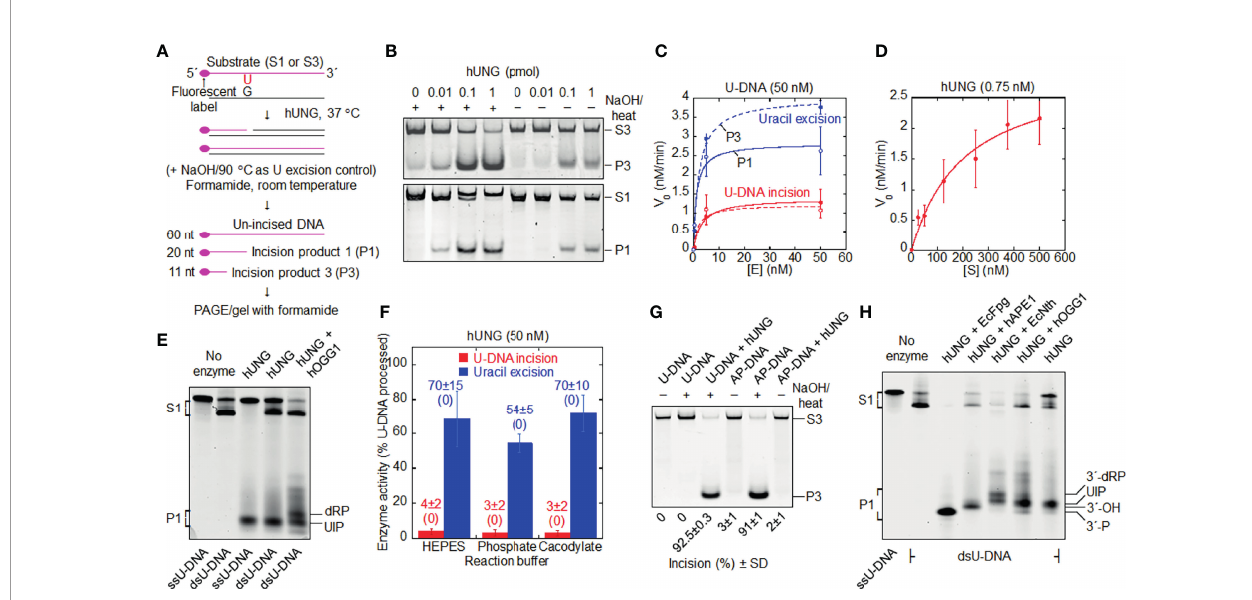
FIGURE 1 | Formation of uracil-DNA incision product (UIP) by hUNG. (A) DNA substrate and base excision assay. Either substrate 1 (S1) or substrate 3 (S3; the base sequences of their labeled strands are presented in Materials and Methods) was exposed to hUNG, resulting in incision product 1 (P1) or incision product 3 (P3), respectively. hUNG (1 pmol) was incubated 10 min with DNA substrate (1 pmol) at 37°C in 45 mM HEPES [4-(2-hydroxyethyl)-1-piperazineethane-sulfonic acid] – KOH, pH 7.8, 0.4 mM EDTA, 1 mM DTT, 70 mM KCl, and 2% (v / v) glycerol (reaction buffer; fi nal volume, 20 µl), if not otherwise stated. (B) Protein dependence of dsU-DNA incision (red) and uracil excision (blue). PAGE was performed at 100 V for 30 min (upper panel) or 50 min (lower panel) using a 12% (w/v) gel, which contained 3% (v/v) formamide, where (C) presents the three to four independent measurements performed. (D) Incision of dsU-DNA by hUNG follows Michaelis – Menten kinetics. hUNG (0.015 pmol) was incubated with an increasing concentration of S1 for 20 min, where the other experimental details are the same as in (B) [except that a 20% (w/v) gel was used]; each value represents the average of 7 independent measurements. (E) Cleavage of ss- and dsU-DNA by hUNG. S1 or its labeled strand was incubated with hUNG alone for 20 min (third and fourth lane), which in one case was followed by incubation together with hOGG1 (3 pmol) for additional 30 min ( fi fth lane). PAGE was performed at 300 V for 7 h using a 20% (w/v) gel containing 7 M urea. (F) Incision of dsU-DNA by hUNG in different buffers. S1 was incubated with and without hUNG in reaction buffer (HEPES), 45 mM sodium cacodylate, or 45 mM potassium phosphate, with the same pH and additions as for reaction buffer (see Supplementary Figure 1 for details). In each case, fi ve independent measurements were performed. Each value represents the average ± SD, where control value without enzyme is shown in parenthesis. (G) No cleavage of dsAP-DNA (U replaced by AP site) by hUNG. dsU- DNA (S3, 1 pmol) was converted to dsAP-DNA by incubation with EcUng (2 pmol) at 37°C for 10 min. AP- or U-DNA was incubated with and without hUNG. PAGE was performed at 100 V for 1 h using a 12% (w/v) gel, which contained 3% (v/v) formamide. The inability of the NaOH/heat treatment to cleave U-DNA as opposed to AP-DNA veri fi ed the integrity of the former as well as the nature of the latter. The complete cleavage of U-DNA by the NaOH/heat treatment following hUNG exposure veri fi ed active enzyme. It should be noted that we always detected UIP in our samples of AP-DNA, which was dif fi cult to avoid since we routinely used EcUng for its preparation. In the AP-DNA sample presented in the fi gure, we succeeded to wash away most UIP during the two precipitation steps employed. Three independent experiments with virtually the same result were performed. (H) Indirect identi fi cation of UIP by its electrophoretic mobility compared to that of characterized enzymes. hUNG (1 pmol) was incubated with S1 (1 pmol); either alone for 20 min (seventh lane), together with EcFpg (4 pmol) for 30 min (third lane), alone for 20 min and thereafter together with hAPE1 (0.45 pmol) for an additional 30 min (fourth lane), together with EcNth (1 pmol) for 30 min ( fi fth lane), or alone for 20 min and thereafter together with hOGG1 (4 pmol) for an additional 30 min (sixth lane). Different incision products were separated from un-incised DNA by PAGE at 300 V for 7 h using a 20% (w/v) gel containing 7 M urea. The experiment with the arrangement presented was performed three times. More than 10 additional experiments were performed with other arrangements to indicate the 3´ incision product. dRP, deoxyribose phosphate; nt, nucleotides; P,